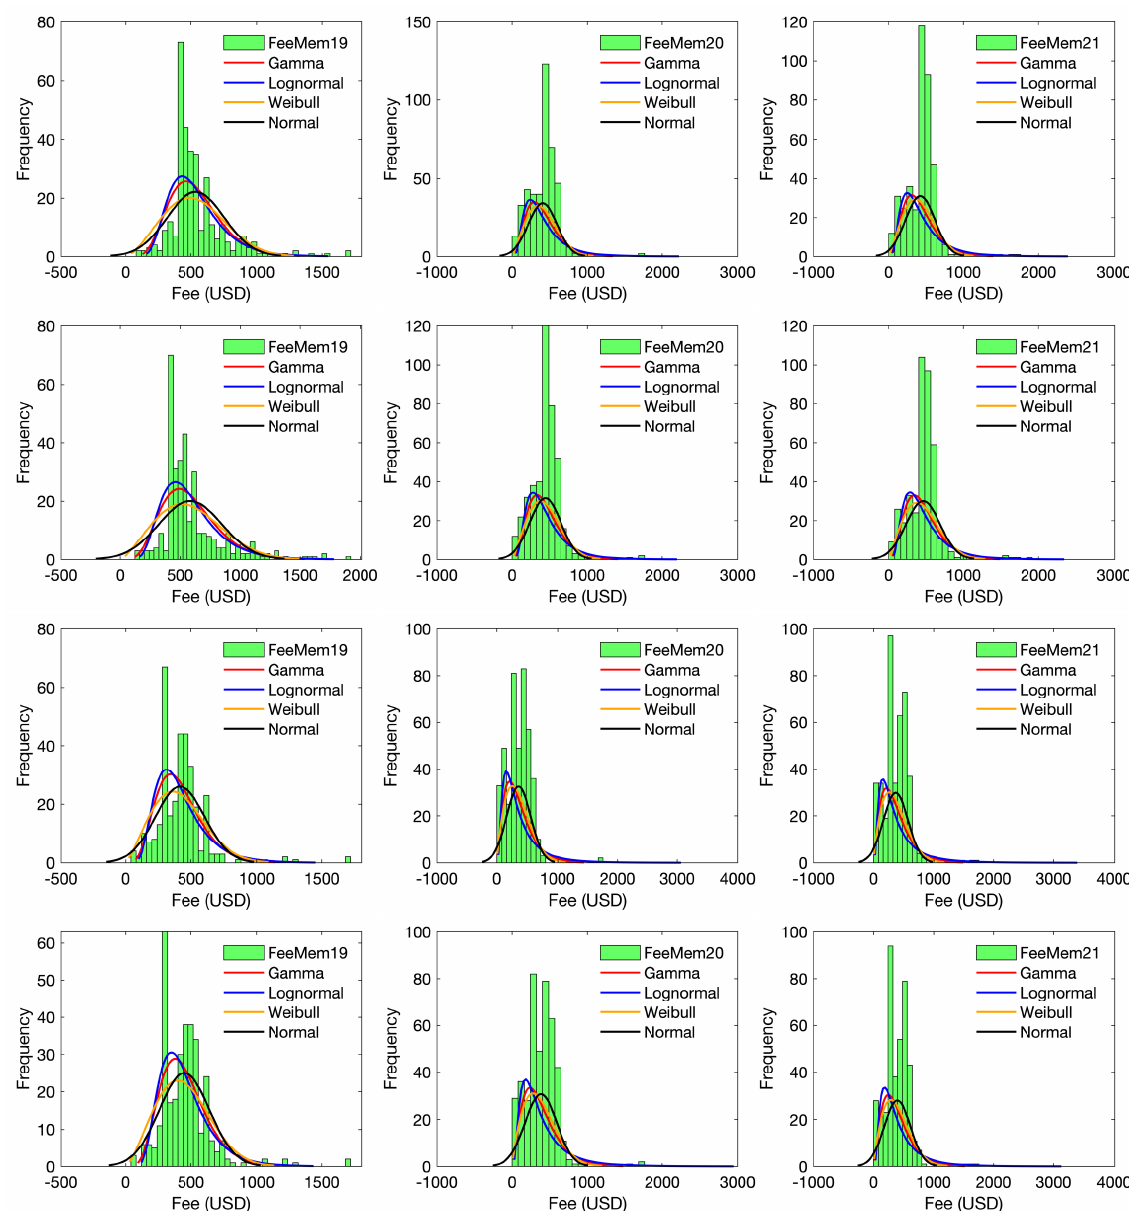
Figure A4. Histograms and curve fittings for the distributions of the four types of registration fees of conferences held in each year. The number of bins is set to be